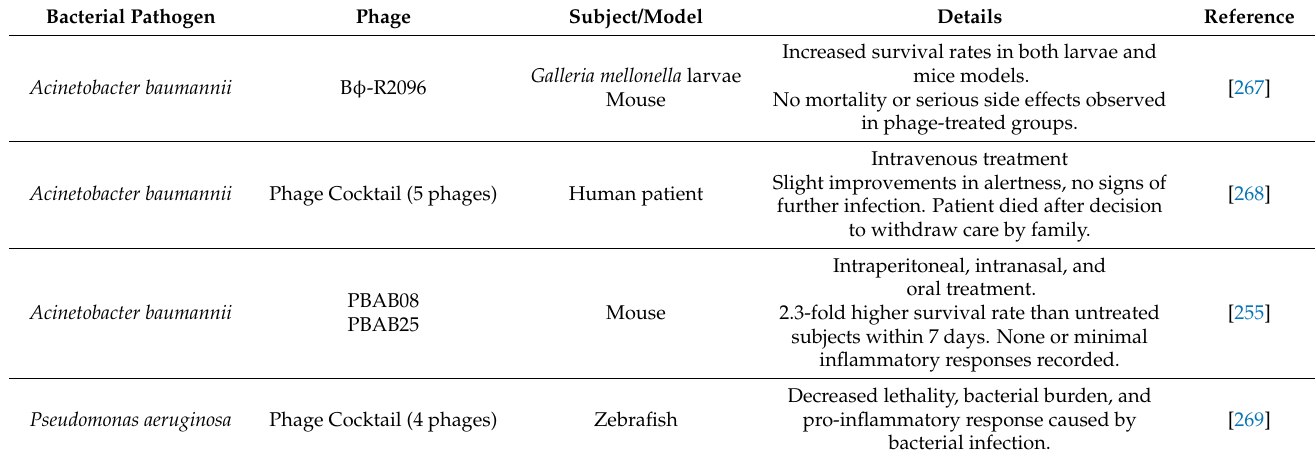
Table 2. Examples of published studies employing bacteriophage therapy with success against bacterial pathogens identified as part of the World Health Organization’s Priority Pathogens since